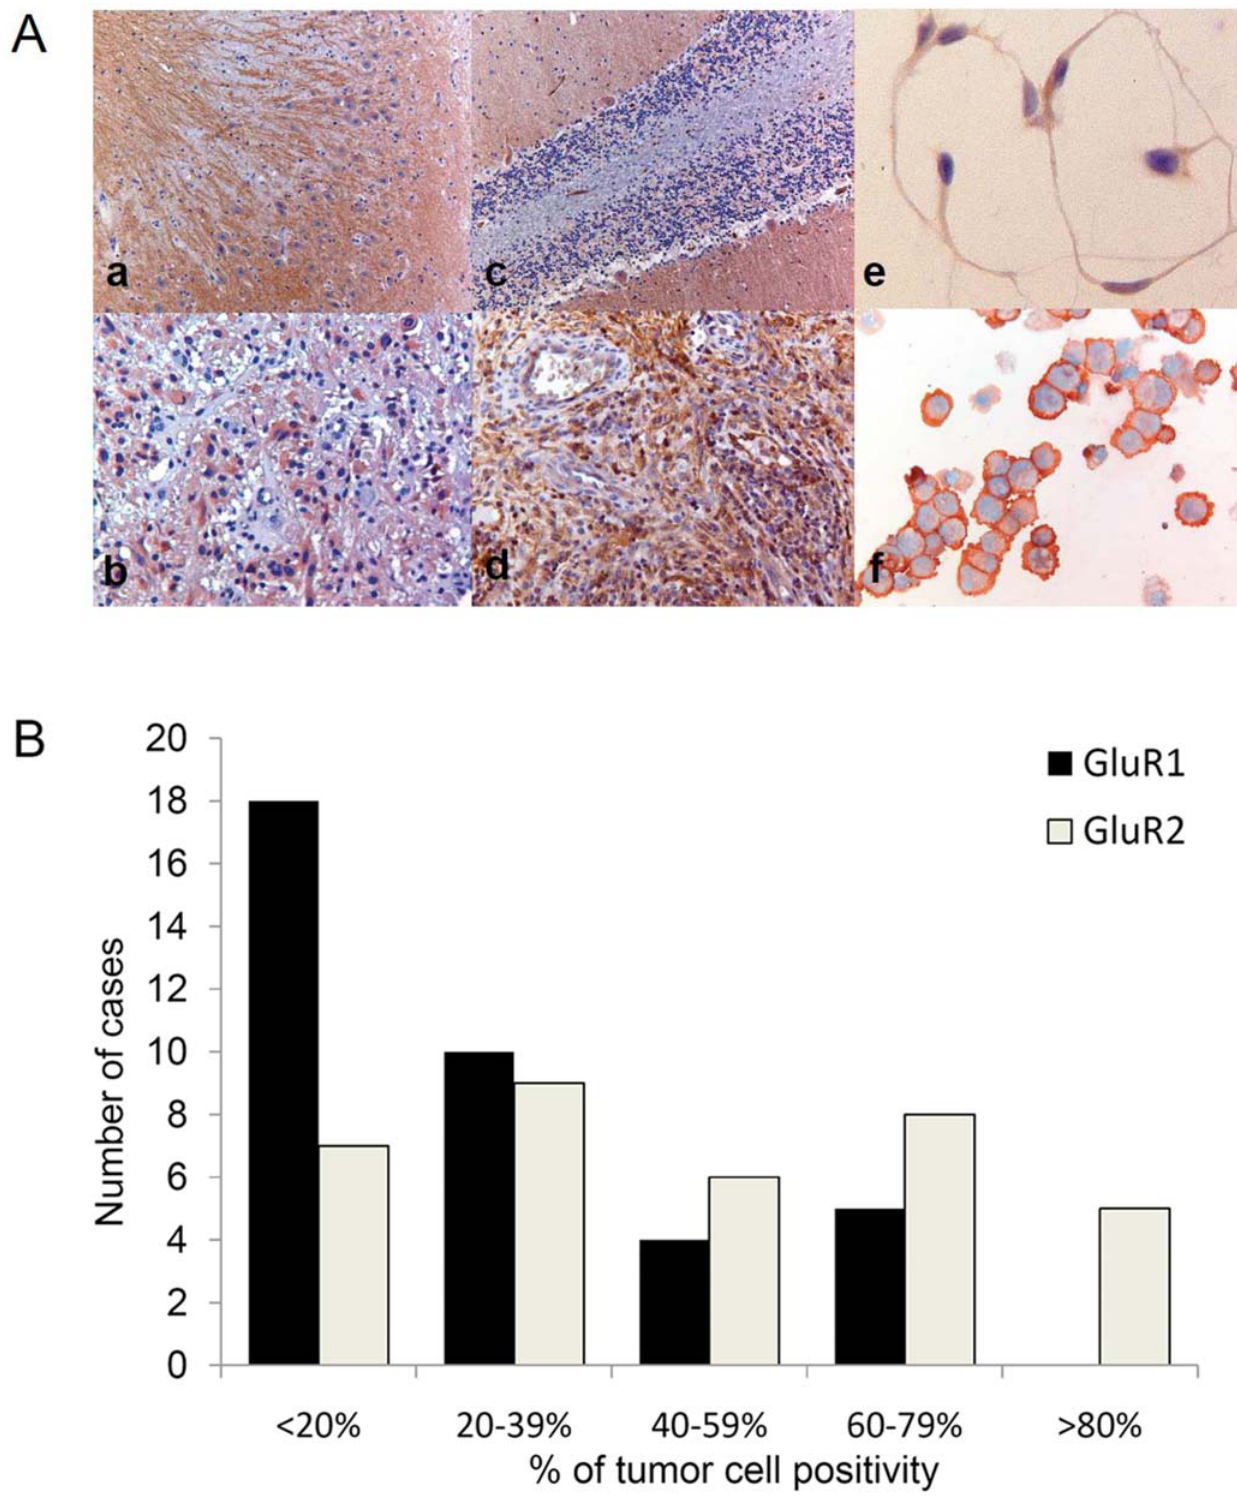
Figure 2. AMPAR immunohistochemistry on paraffin embedded sections. (A) Representative images of (a) GluR1 in hippocampus, (b) GluR1 in GBM, (c) GluR2 in cerebellum, (d) GluR2 in GBM, (e) GluR2 staining in chamberslide of VU-122 cell line, (f) GluR2 staining in cytospin of VU- 122. (B) Histogram of protein expression of GluR1 and GluR2 in 37 cases of adult GBM.